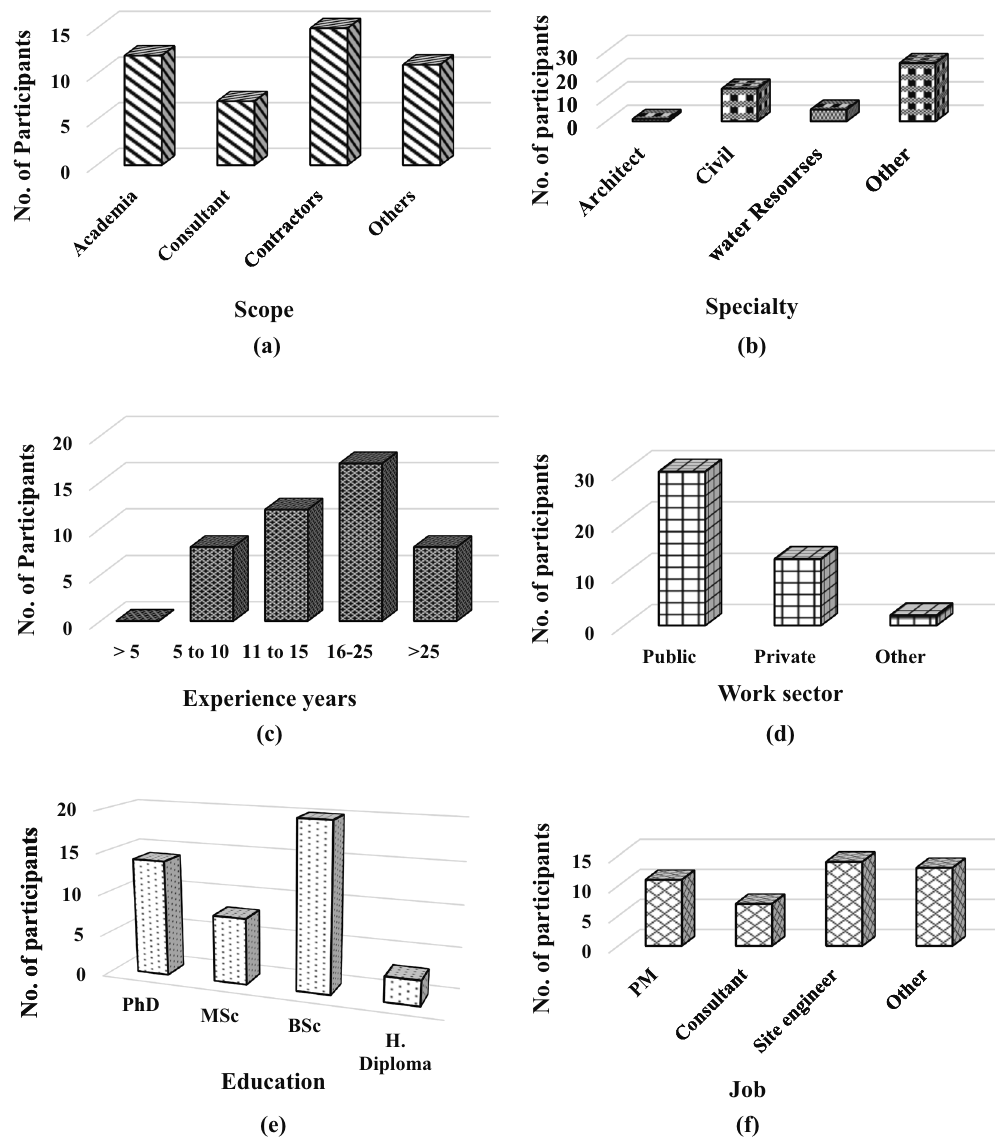
Figure 3: Stakeholders ’ demographic analysis: ( a ) scope of work, ( b ) work specialization, ( c ) years of experience, ( d ) sector of work, ( e ) education degree, and ( f ) job title.